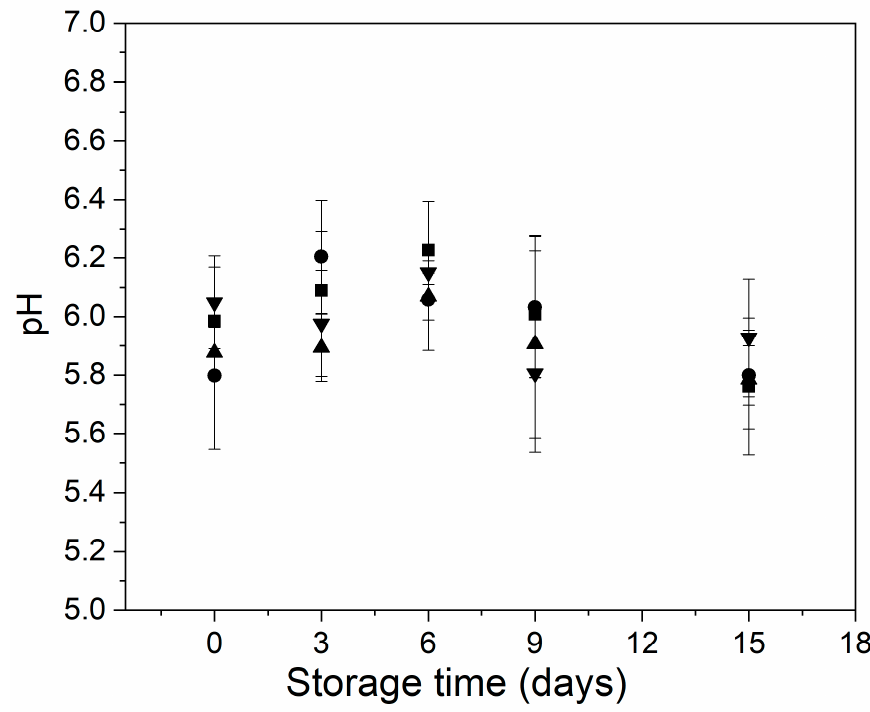
Figure 3. Behavior of the pH of control and treated minimally processed bunching green onions during storage. Control ( ■ ); mild-heat treatment ( ● ); edible coating ( ▲ ); mild-heat treatment+ edible coating ( ▼ ).